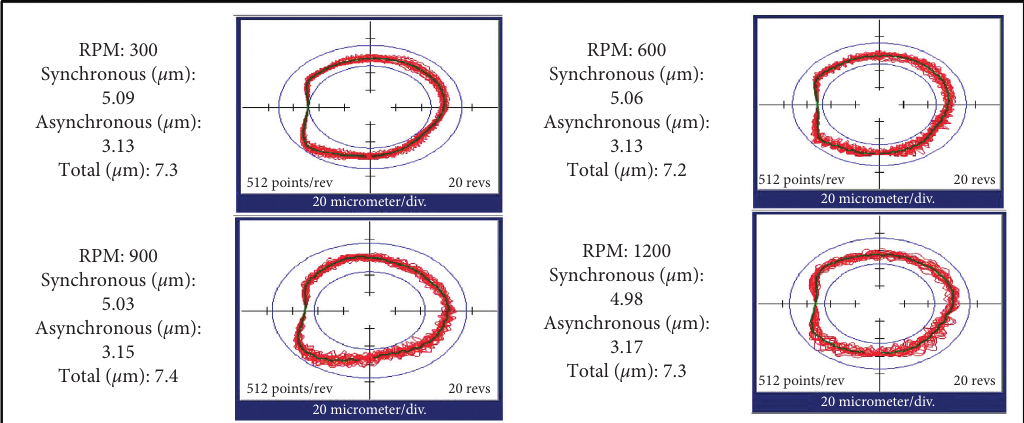
Figure 10: Rotation error track of the spindle at different